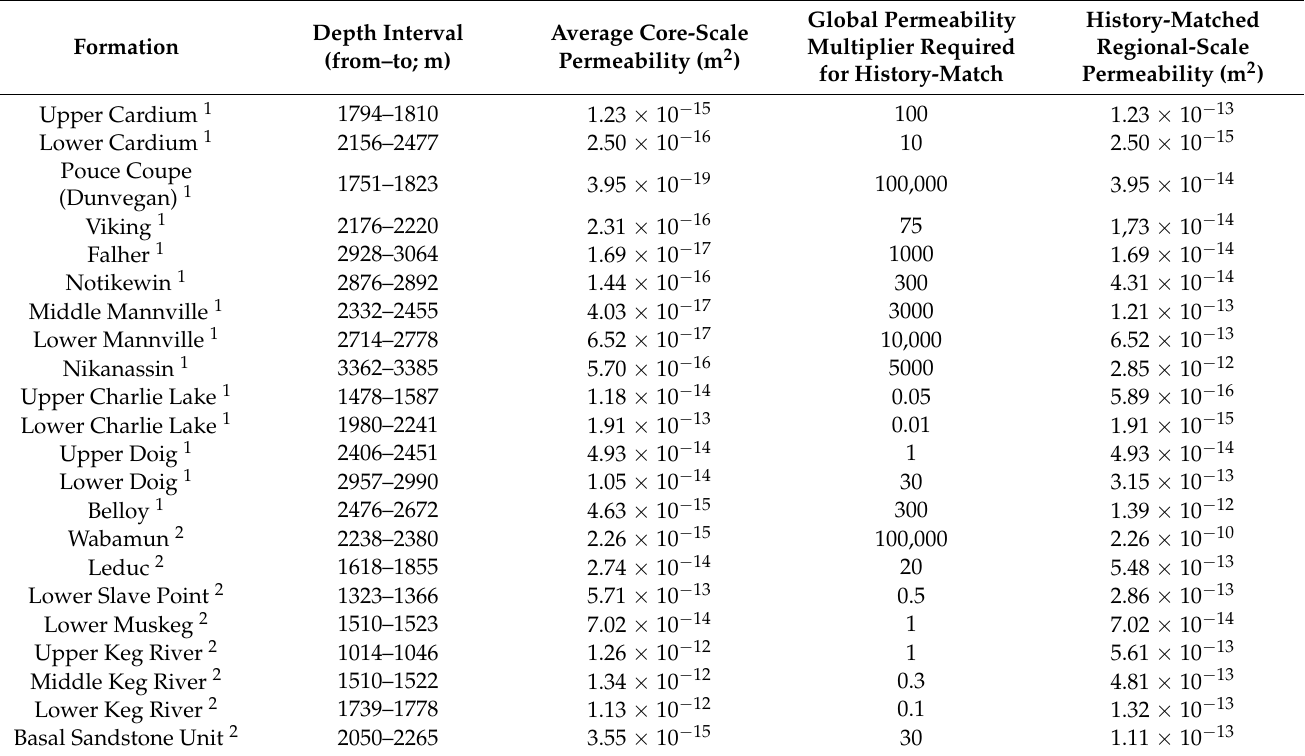
Table 5. History-matched regional-scale permeability values for formations of